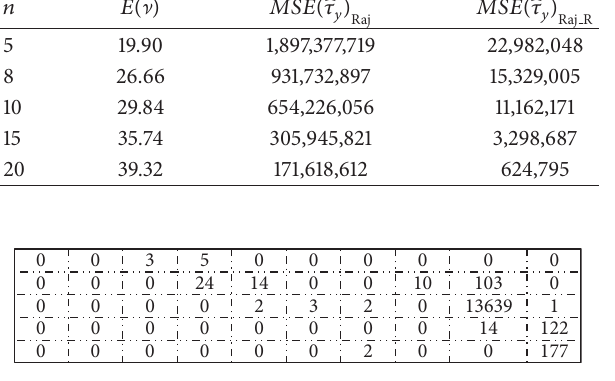
Figure 1: Blue-winged teal data ( 𝑦 -values).